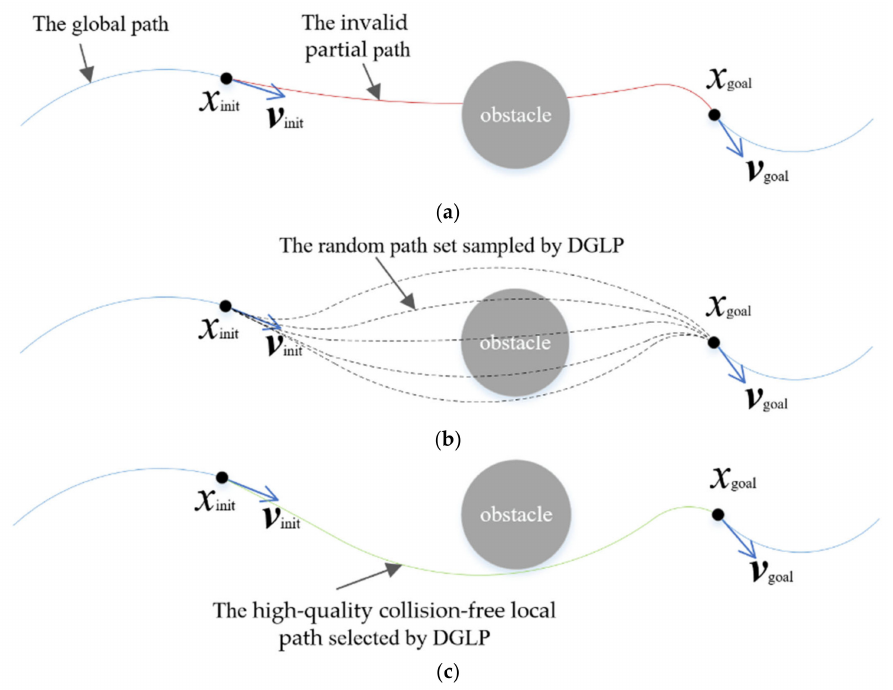
Figure 1. The DGLP plans the local path. The x init and x goal are the initial node and the goal node of the local re-planning. The v init and v goal are the velocities at the x init and x goal . Dashed curves represent a set of random paths. ( a ) A part of the global path is invalid because of the dynamic obstacle. ( b ) The DGLP samples n p random paths that satisfy the path end orientation constraints. ( c ) The DGLP selects the high-quality collision-free local path from the random path set.